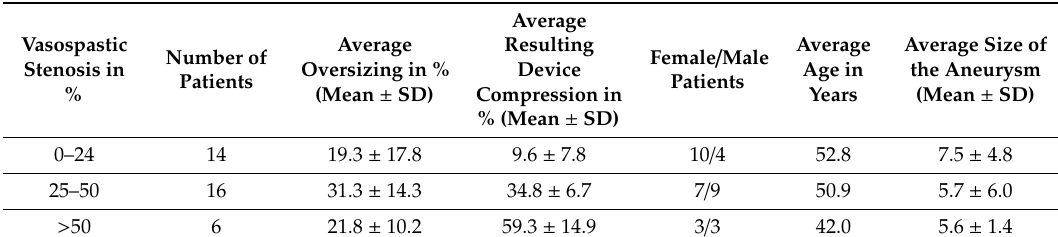
Table 2. Summary of results after grouping our patients according to their individual degree of vasospastic